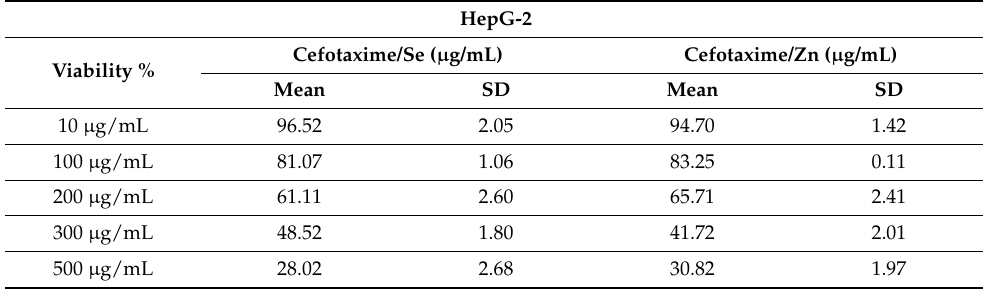
Table 6. Anticancer activity of cefotaxime and its metal complexes (cefotaxime/Se, and